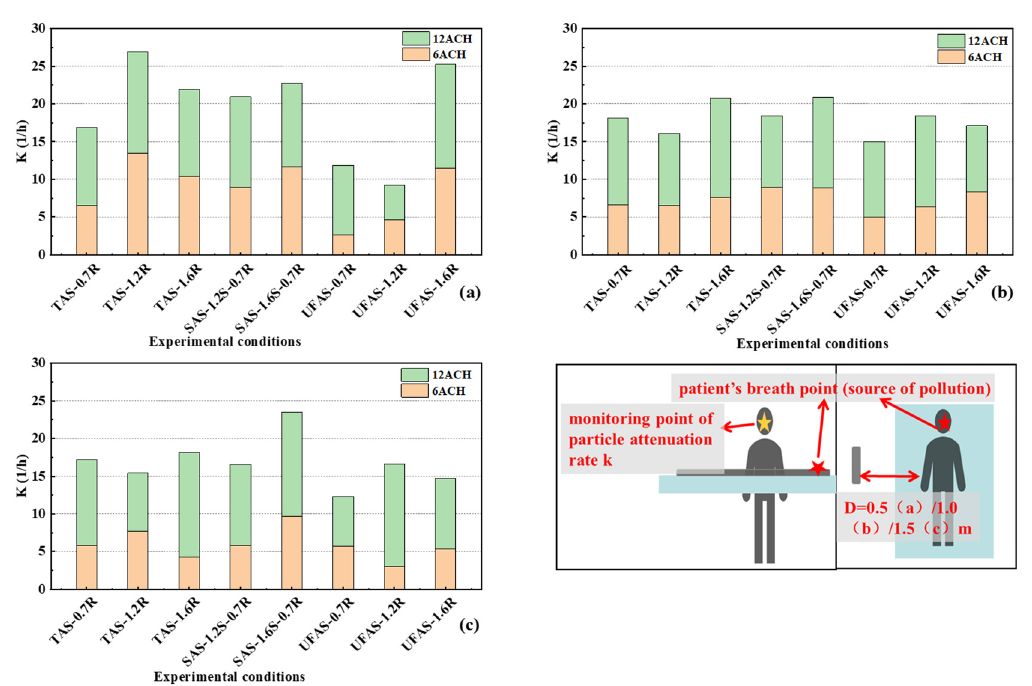
Figure 7. Particle concentration decay rate k at different distances between medical staff and patients. ( a ), ( b ) and ( c ) represent the distance between the medical staff and the patient at 0.5 m, 1.0 m and 1.5 m, respectively.